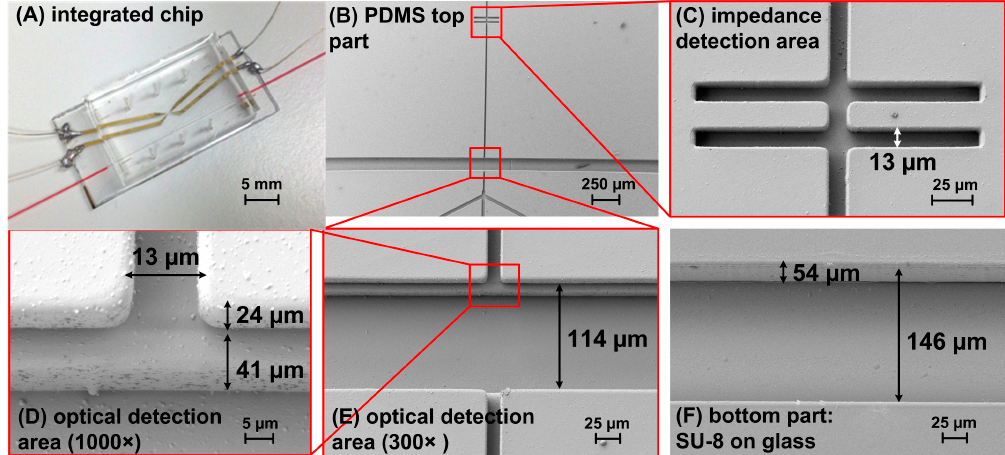
Figure 3. ( A ) Photography of a hybrid chip integrated with electrodes and optical fibers; ( B – F ) scanning electron micrographs of the components of the microfluidic chip showing the configuration without the wall in between the optical fibers: ( B ) top part of the chip fabricated in PDMS; ( C ) zoom-in showing the details of the impedance detection area; ( D ) optical detection area at magnification 1000× and ( E ) 300×; and ( F ) bottom part of the chip: SU-8 inferior layer on a glass substrate.